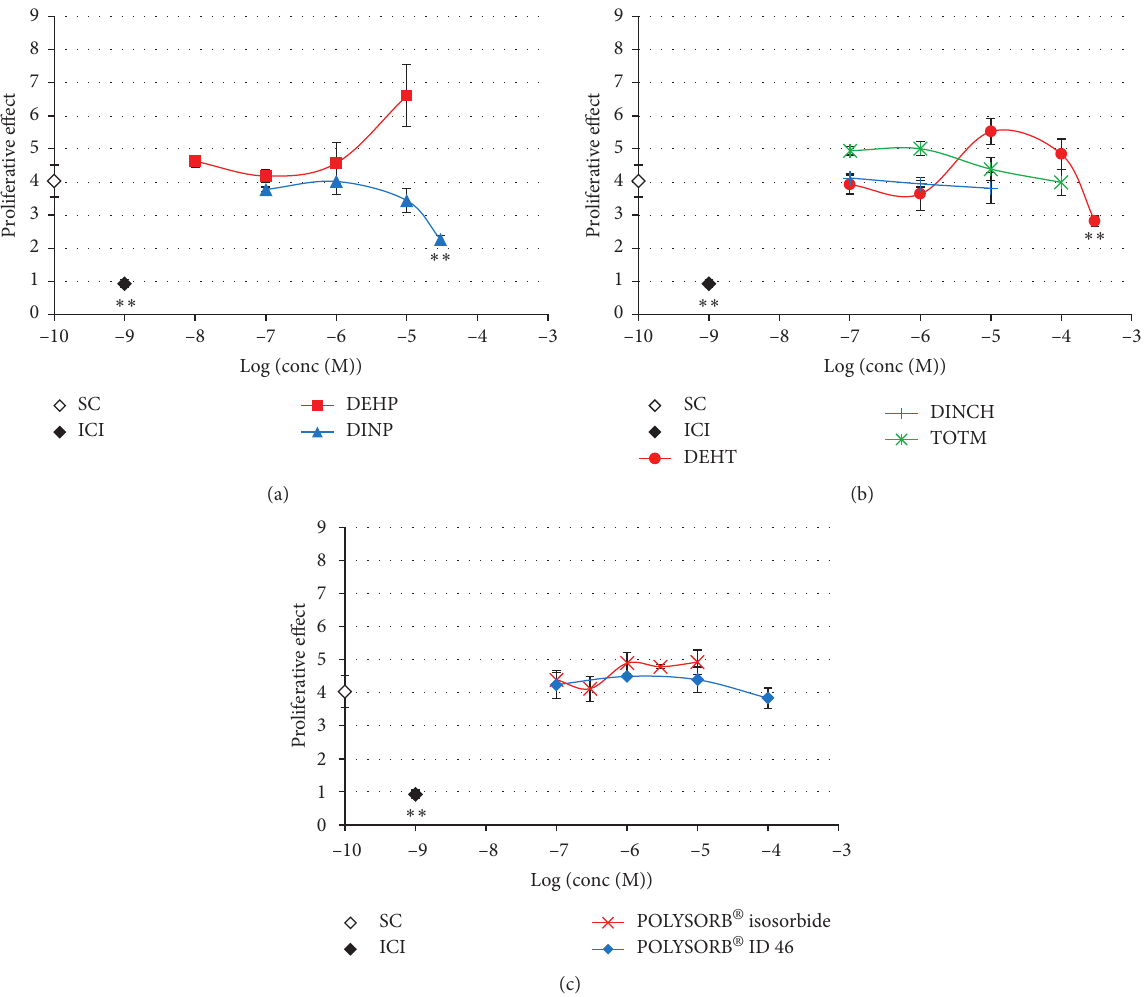
Figure 3: Antiestrogenic activity of phthalates and substitutes in the E-Screen antagonist assay. MCF-7 cells were exposed for 120h to different concentrations of DEHP, DINP (a), DEHT, DINCH, TOTM (b), POLYSORB ® isosorbide, or POLYSORB ® ID 46 (c) in presence of 1pM E2. Solvent (SC) and ICI 182,780 (ICI) were used as controls. Results represent the mean proliferative effect compared to the solvent control without E2 ( � 1) ± SD of 3 replicates from one representative assay out of 2 assays. ∗∗ Statistically significant decrease compared to SC with E2 ( p < 0 .